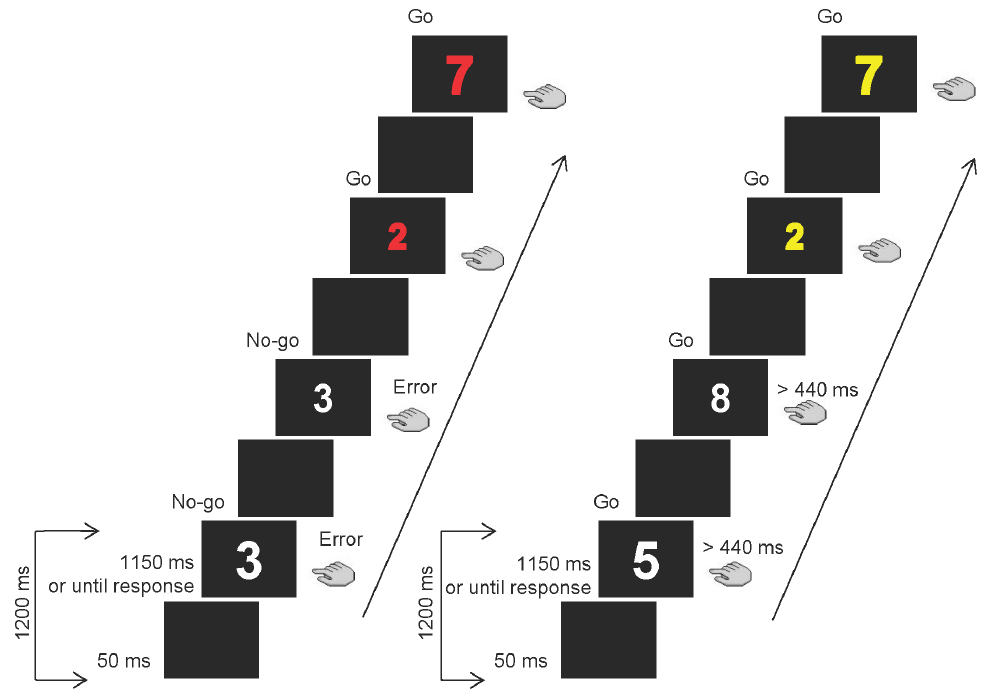
Figure 1. Sequence of events for both strategy conditions in the modified SART. The precision strategy condition, on the left, emphasised accurate response inhibition over fast responding. Digits turned red when the average correct response rate in no-go trials was below 0.71. The speed strategy condition, on the right, emphasised fast over correctly inhibited responses. Digits were presented in yellow when the average RT was above 440 ms and accuracy rate in no-go trials was not below 0.45.